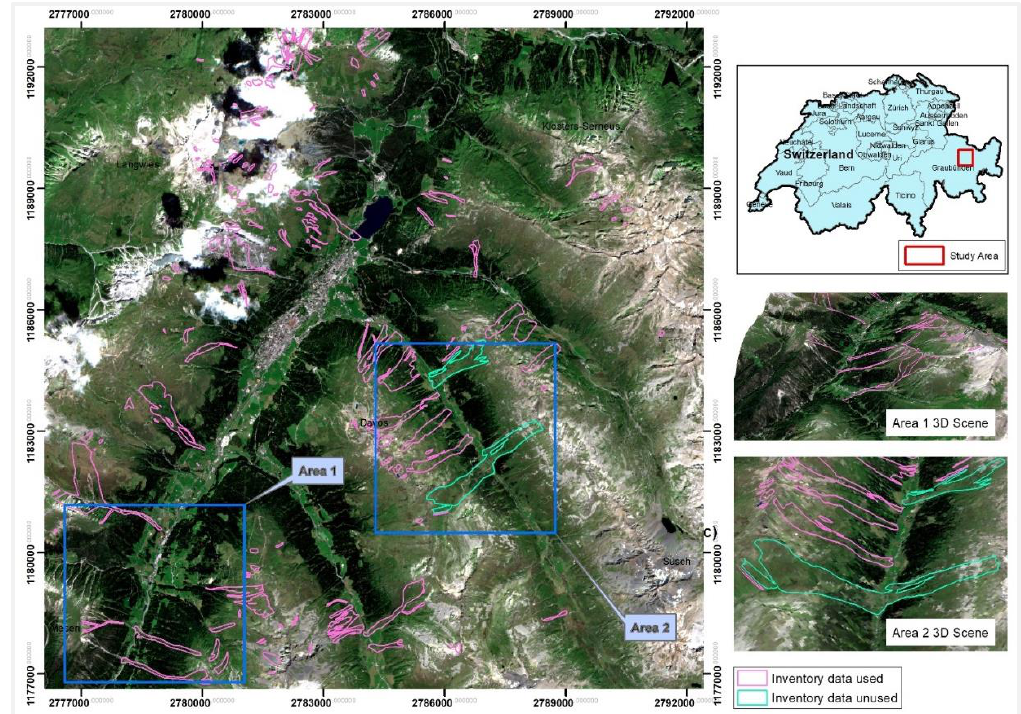
Figure 1. The location map, the satellite image of the study site and the avalanche